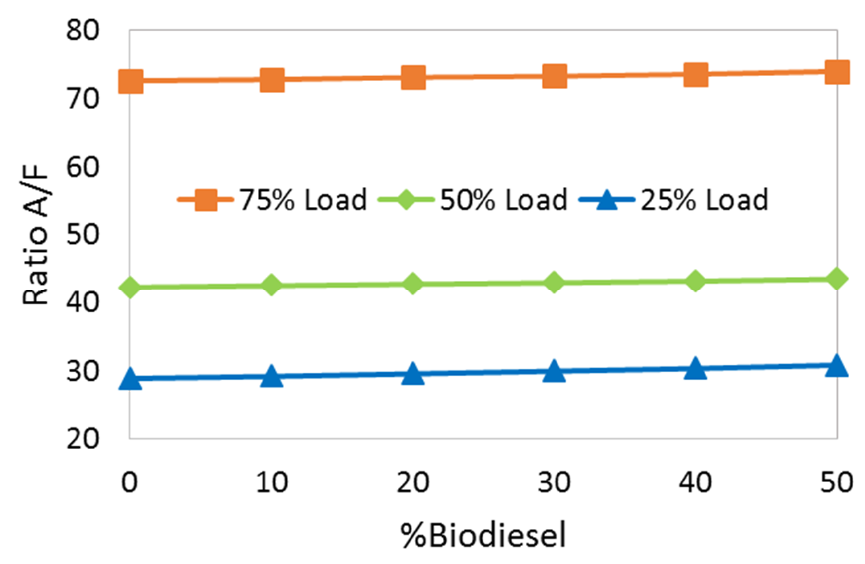
Figure 7. A/F ratio with biodiesel blends.